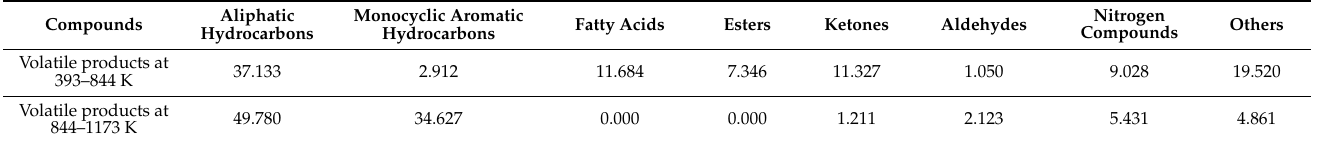
Table 9. Classification of volatile products from cold-rolling oil sludge pyrolysis by GC/MS (area